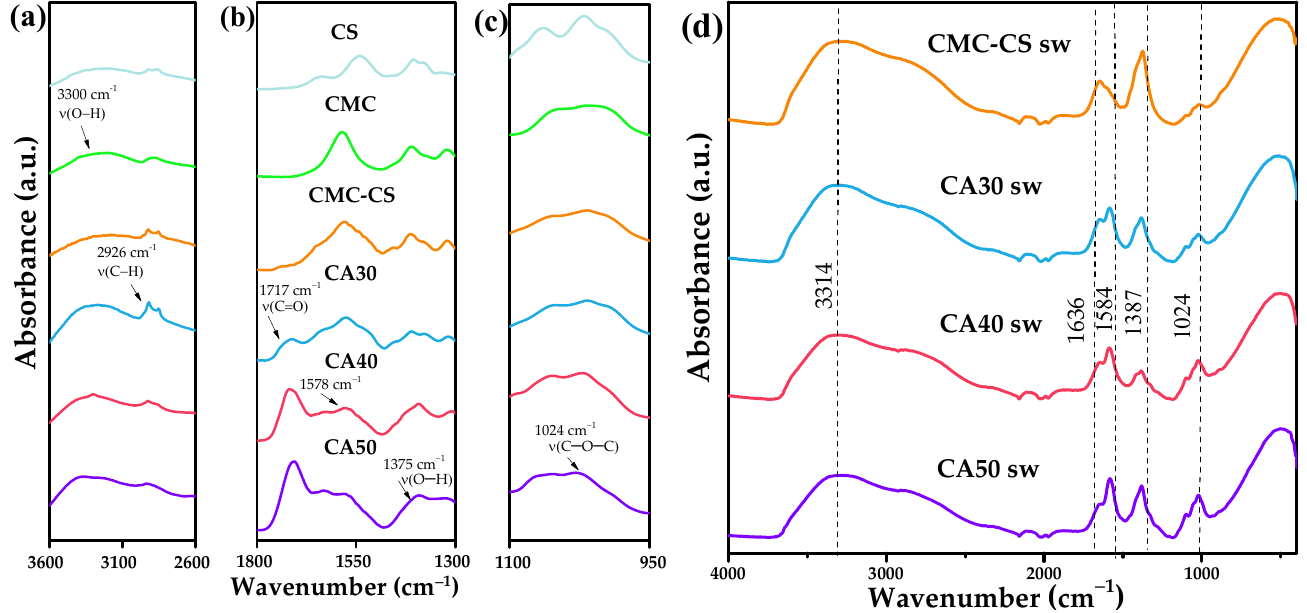
Figure 3. ATR-FTIR spectra of ( a ) CS, ( b ) CMC, ( c ) CMC–CS, and ( d ) CMC–CS sw hydrogels at different CA proportions.